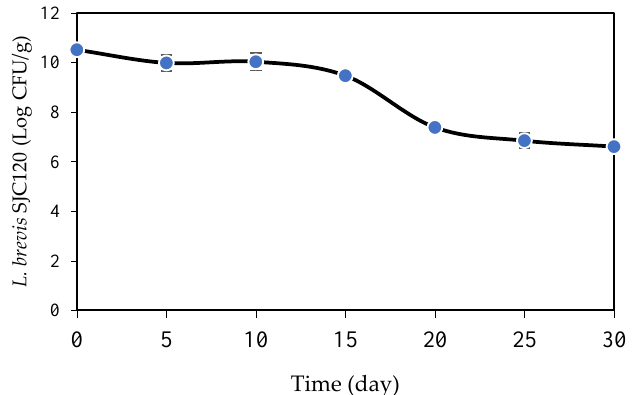
Figure 4. Number of viable L. brevis SJC120 (expressed as Log CFU/g) in whey–gelatin films during storage time (day) at 10 °C. Values are the mean ± SEM ( n = 3).